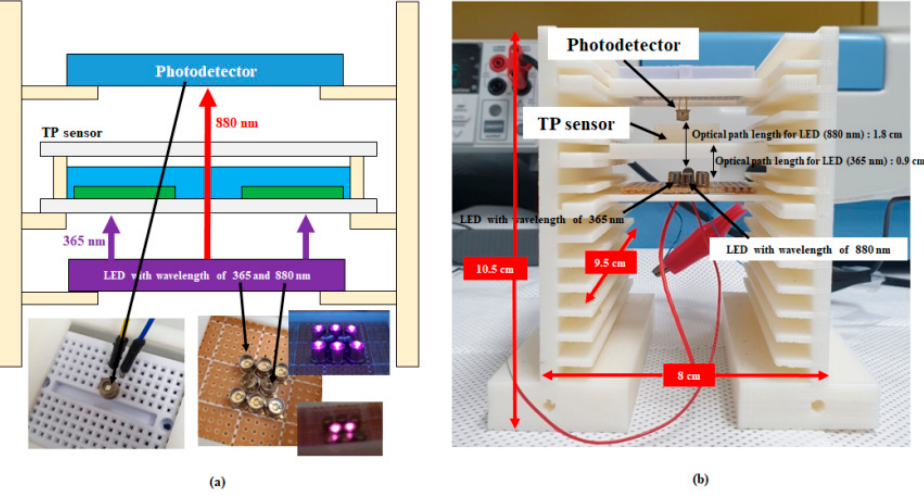
Figure 5. ( a ) Schematic and ( b ) picture of the miniaturized portable TP analysis device with the TP sensor.